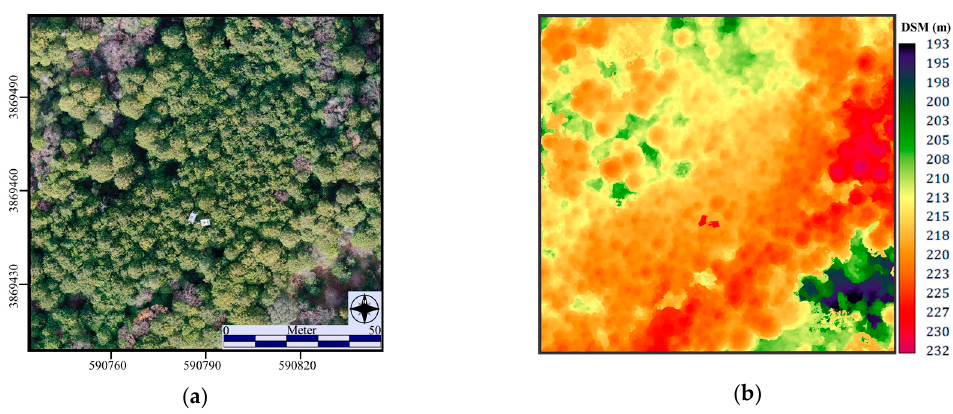
Figure 3. ( a ) Orthoimage of the study site, and ( b ) DSM generated from the aerial imageries and the structure from motion (SfM) method. 345 images taken from the flight, the SfM method was successfully applied to the site.